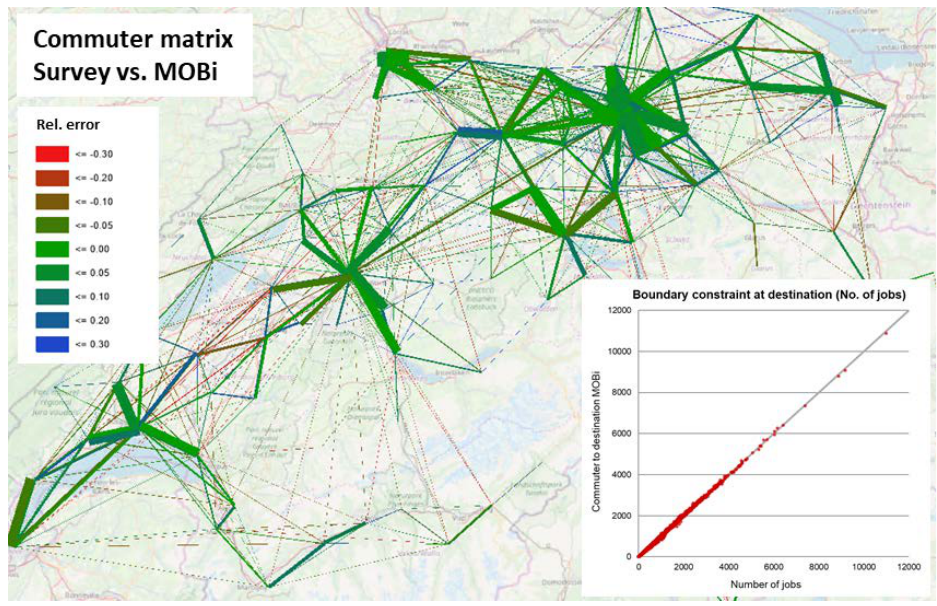
Figure 5. Commuter flows in SIMBA